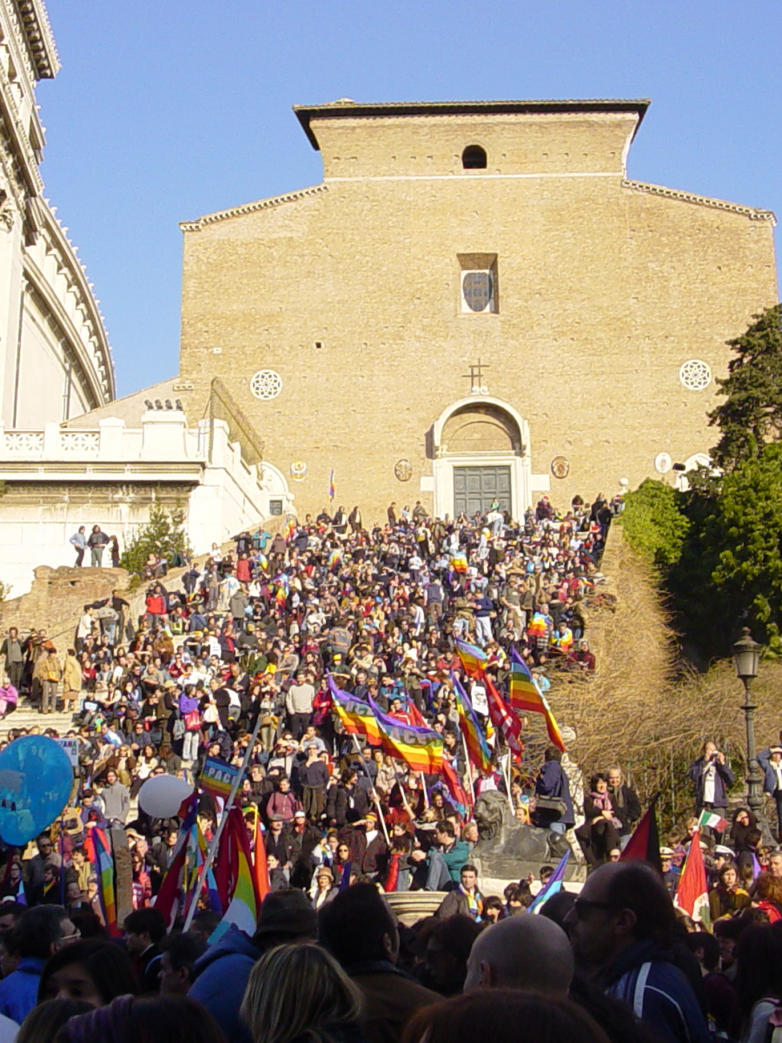
The probability of being sure you saw something you didn't increases in chaotic environments like this 2003 peace rally near the Campidoglio in Rome. (Image: Stefano Baldassi)